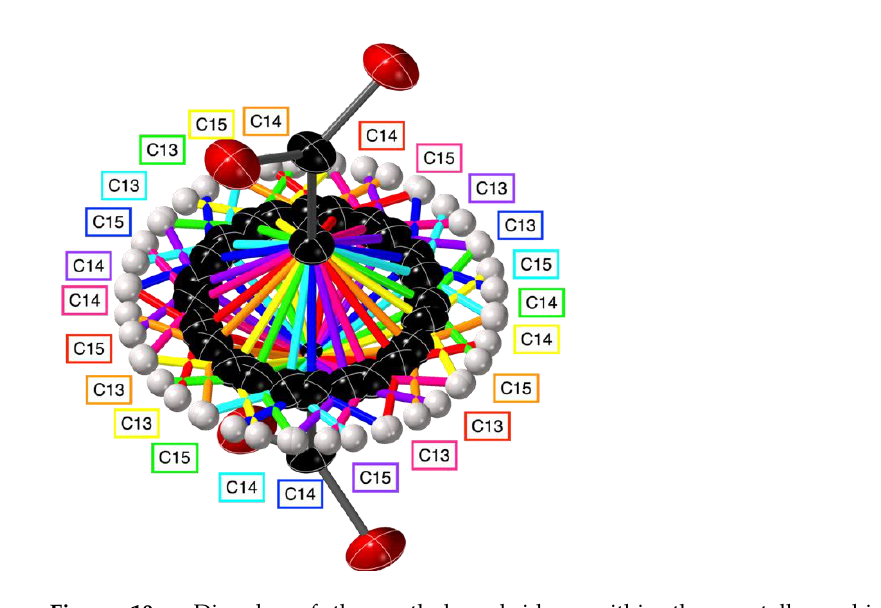
Figure 10. Disorder of the methylene bridges within the crystallographically identified bicyclo[1.1.1]pentane-1,3-dicarboxylate; each of the eight colors (red, orange, yellow, green, light blue, dark blue, purple, and pink) represents a 1/8 occupancy of the disordered (CH 2 ) 3 units.